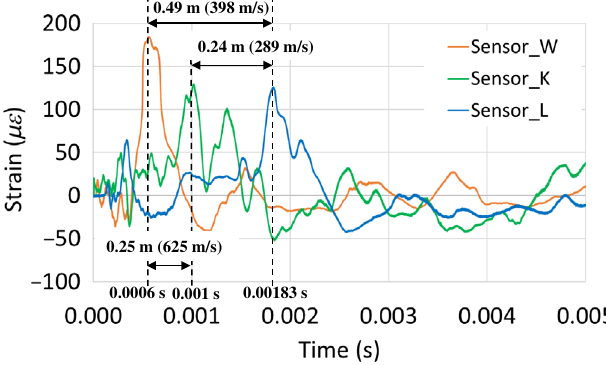
FIG. 24. Example strain responses of transverse-oriented sen- sors on the top inlet side and apparent deformation propagation speeds.